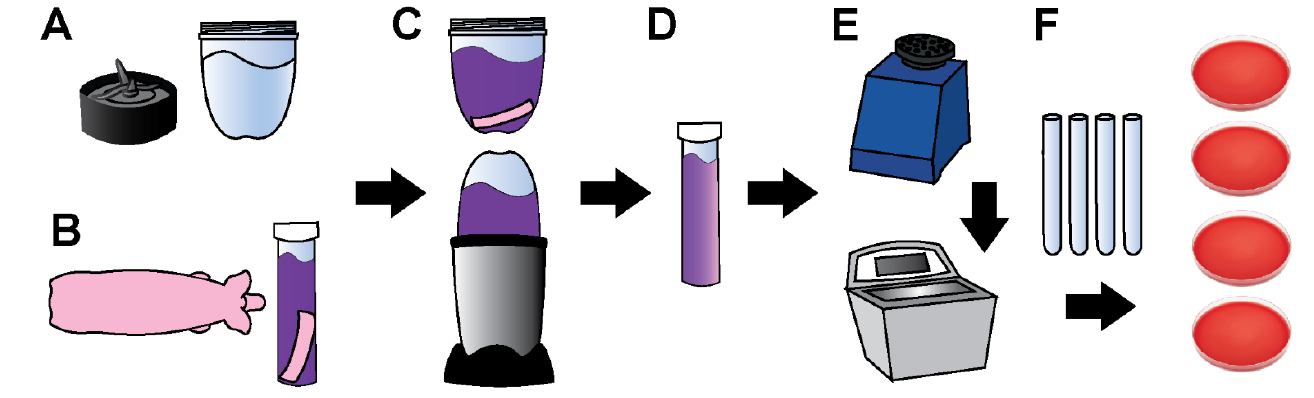
Figure 3. Sequential method for processing skin tissues collected and processed using PSP model using full-thickness samples: ( A ) Cold sterilization of magic bullet blenders with 200 proof ethanol; ( B ) Square skin samples (4 cm by 4 cm) placed in 35 mL of D/E neutralizing broth; ( C ) Sample blended for approximately 5 min; ( D ) Sample transferred back to the original conical tube; ( E ) Sample vortexed for 1 min, sonicated for 10 min, vortexed for 10 s; ( F ) 10-fold serial dilution performed in PBS. The 10 0 dilution and 10 − 1 –10 − 4 dilutions were plated in duplicate on separate Columbia blood agar and incubated in aerobic or anaerobic conditions.